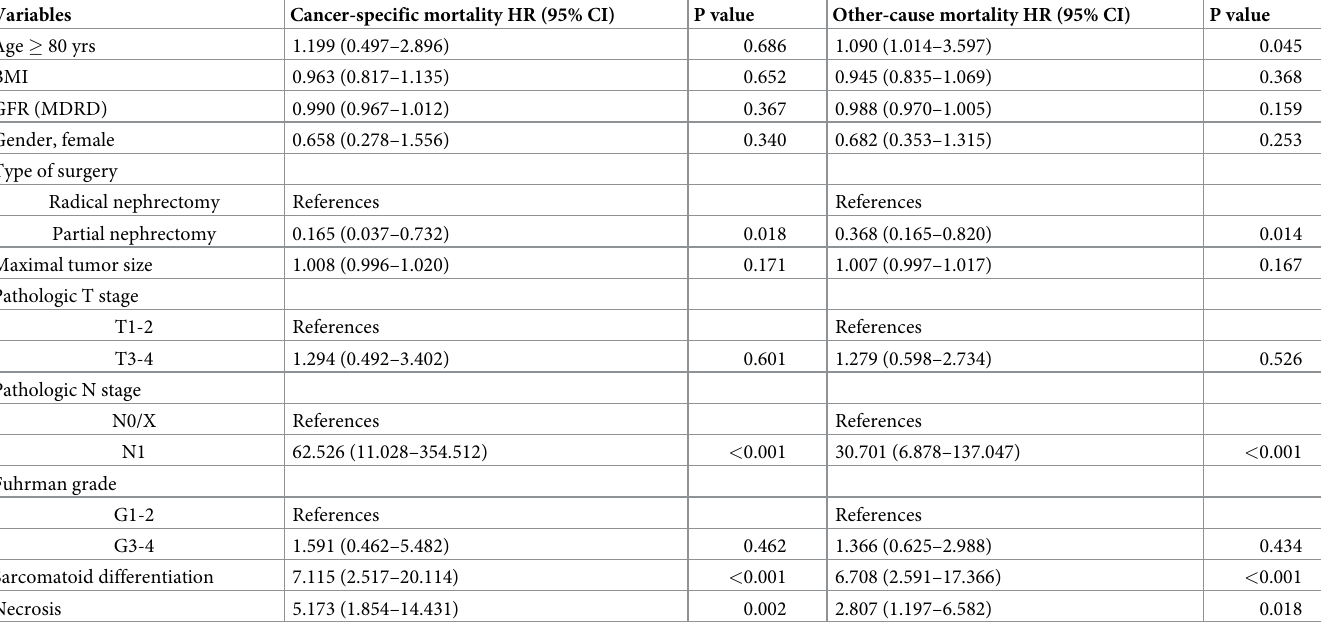
Table 2. Multivariable Cox regression analyses for cancer-specific and other-cause mortality after propensity score